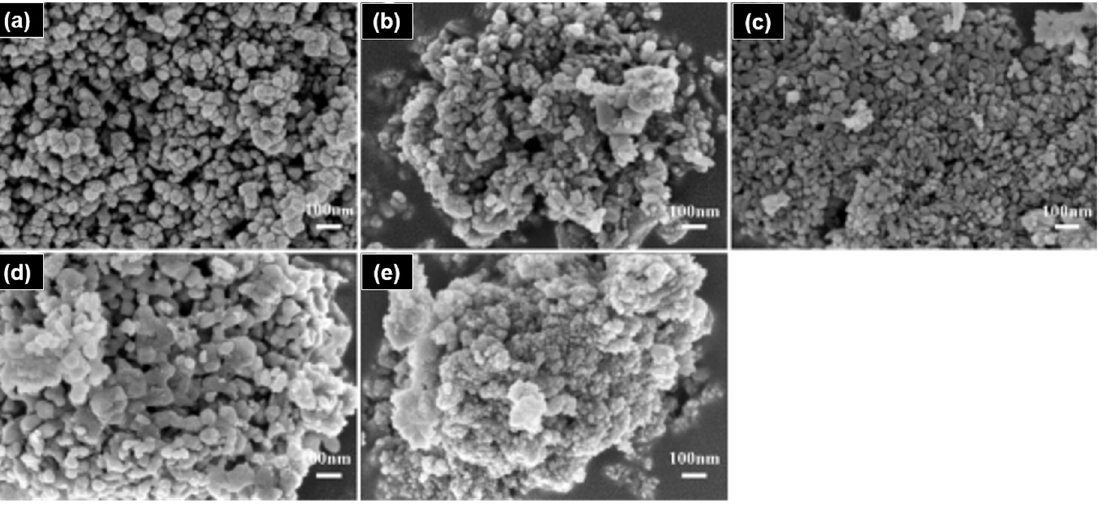
Figure 5. SEM images of the catalysts: ( a ) MF, ( b ) Ce 0.05 -MF, ( c ) Ce 0.1 -MF, ( d ) Ce 0.2 -MF, and ( e ) Ce 0.4 -MF.